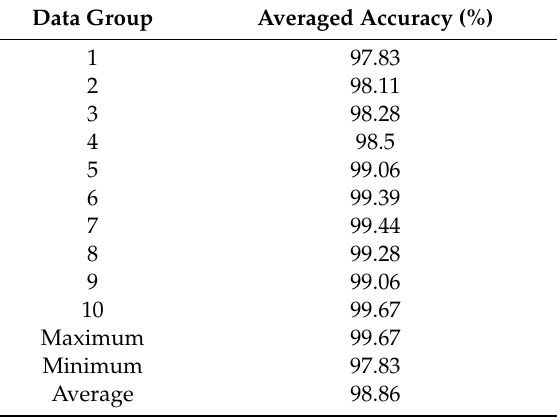
Table 4. Binary classification results of the SVM for signals of length 7 s with six